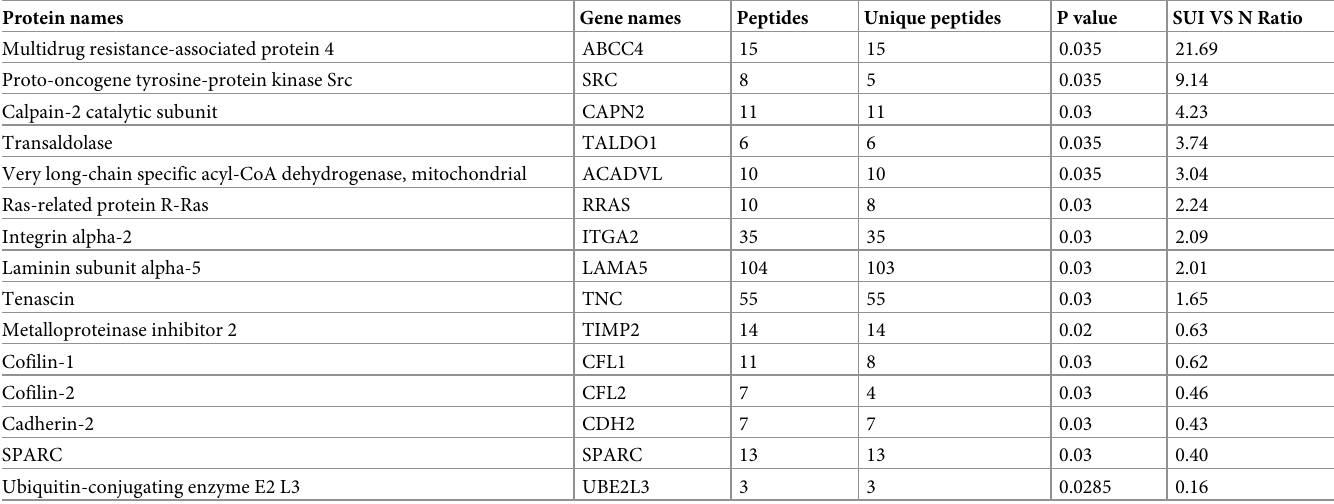
Table 1. Proteins differentially regulated in sEVs isolated from SUI